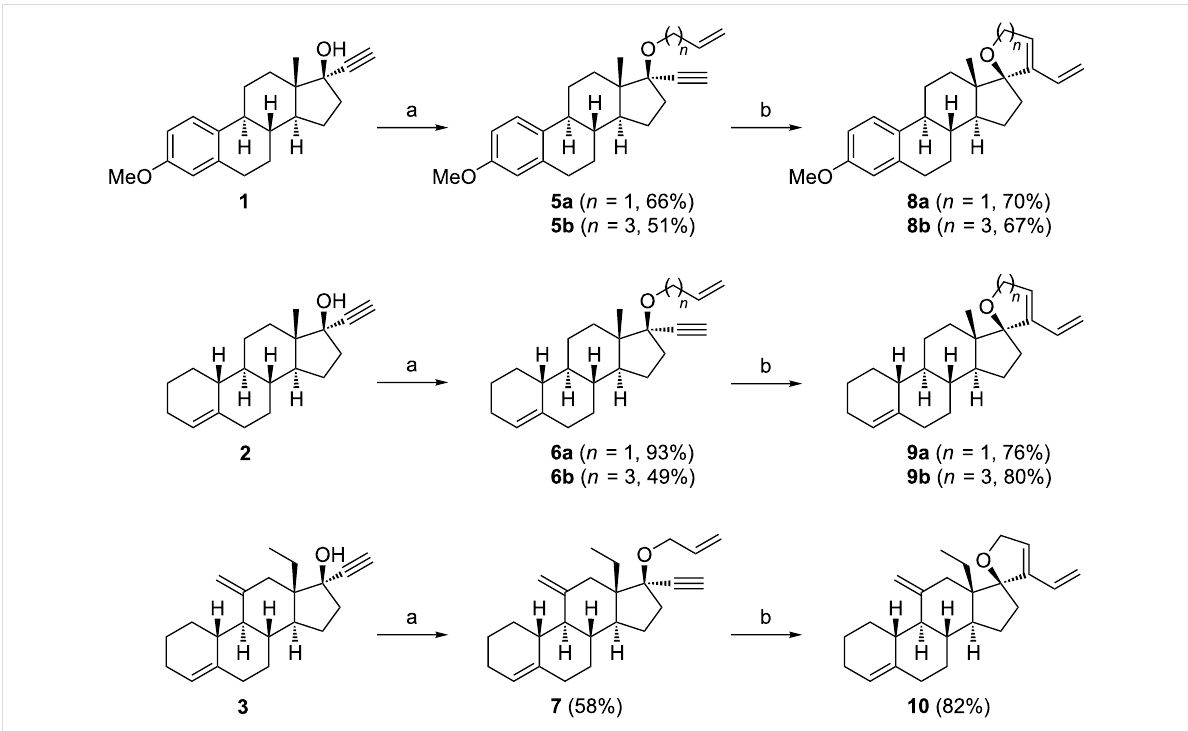
in good yields and were readily engaged in the RCEYM reac-